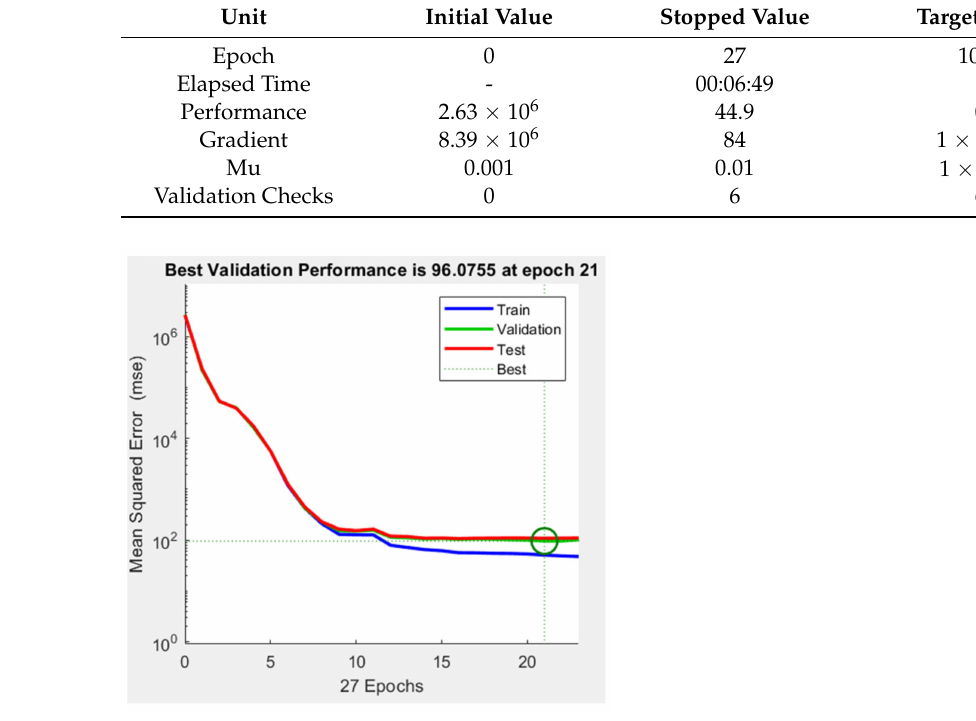
Figure 4. ANN teaching performance.